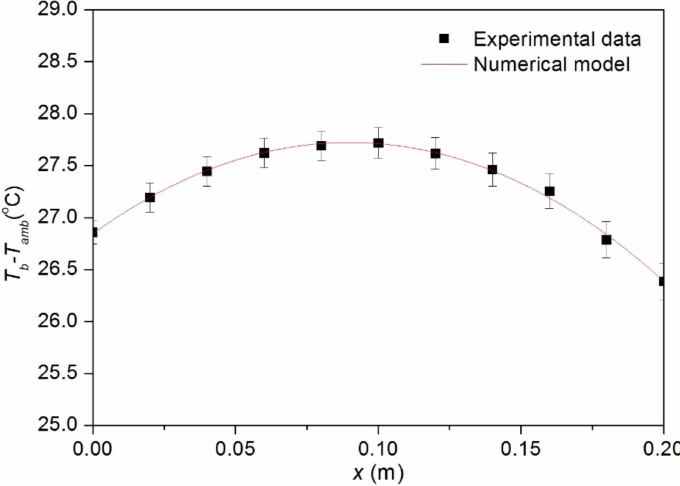
Figure A1. Comparison of temperature di ff erences from experimental data and results of the numerical model for L h / L of 1, channel width of 3 mm, flow rate of 0 m 3 / min, and heat input of 5 W.